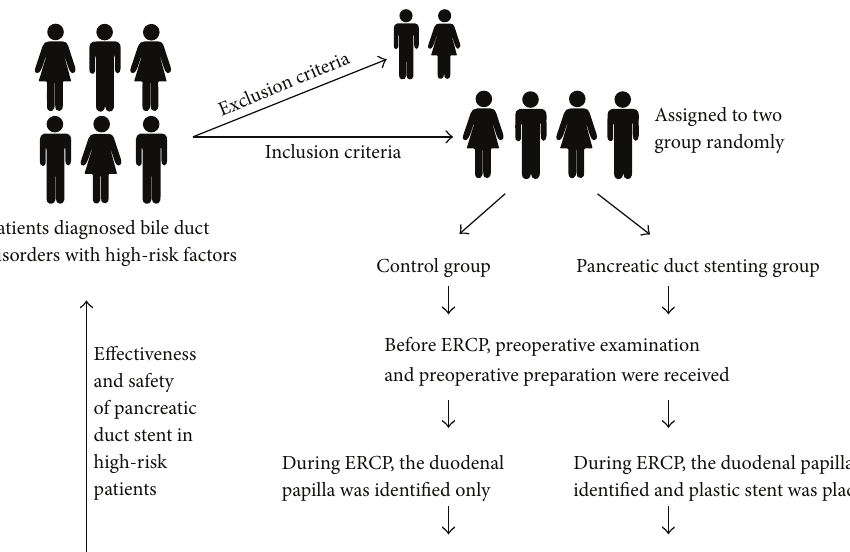
Figure 1: Patient assignment